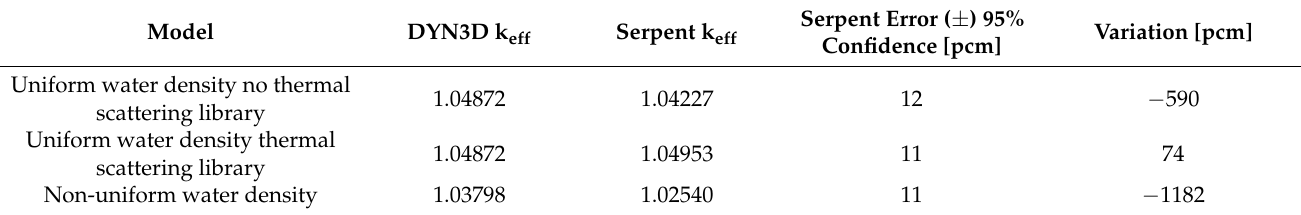
Table 3. Comparison of the reactivity coefficients of the single assembly with a uniform fuel material.